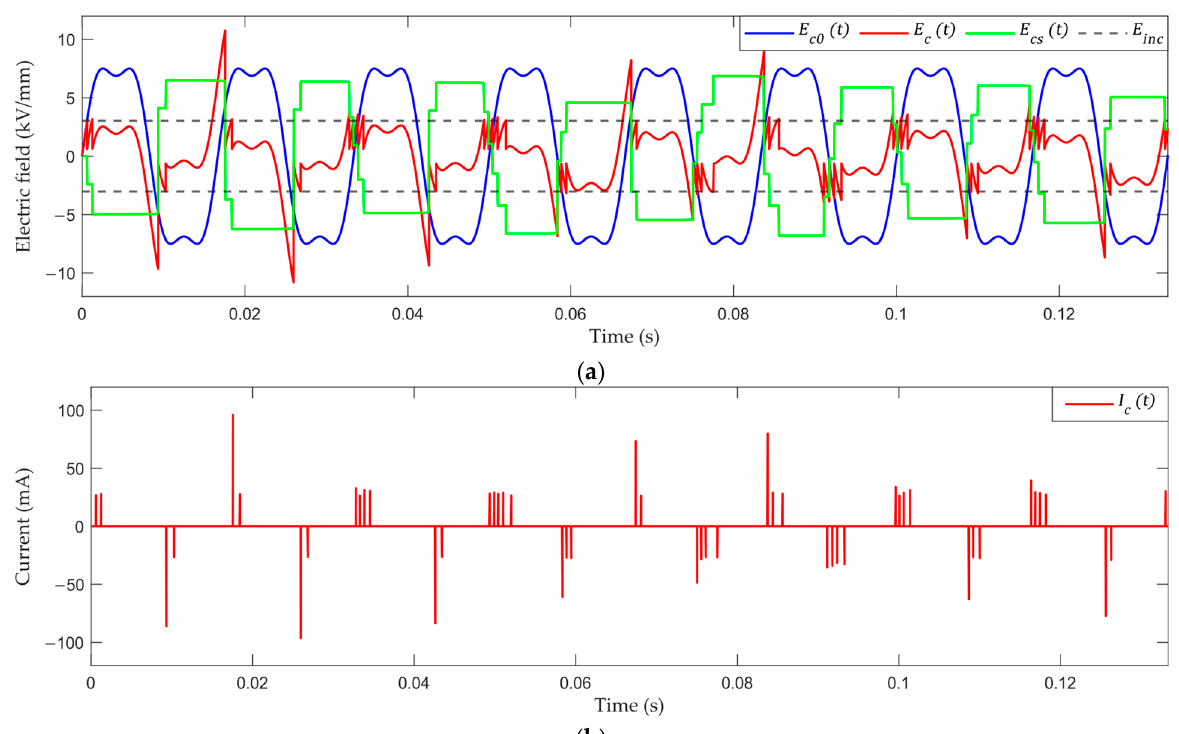
Figure 5. Simulated results for the case wherein a voltage distorted by the 3rd harmonic component with ϕ h = 0 ◦ and THD = 20% was applied: ( a ) electric fields over time; ( b ) PDs’ current pulses.